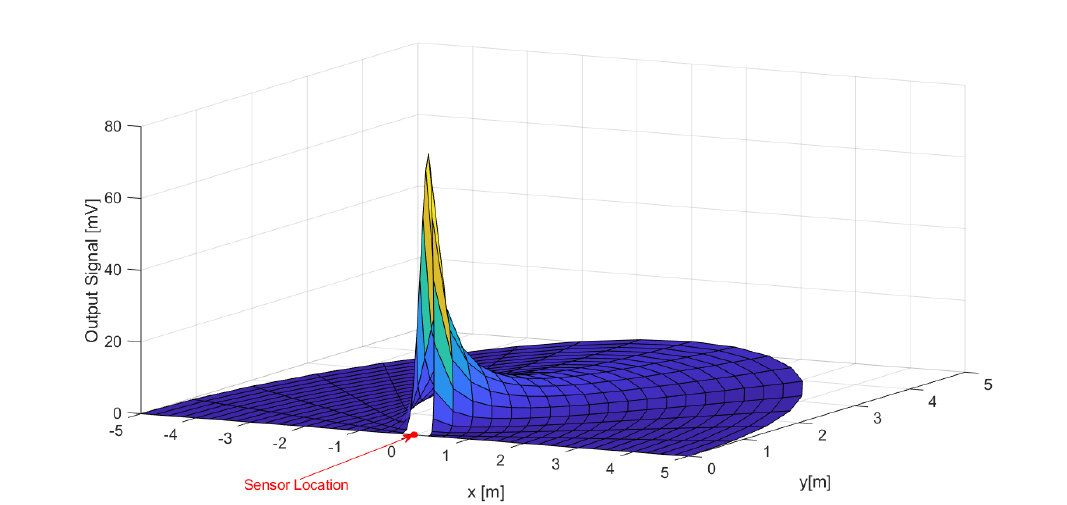
Figure 18. 3-D graphical representation of the derived fit in cartesian coordinates.